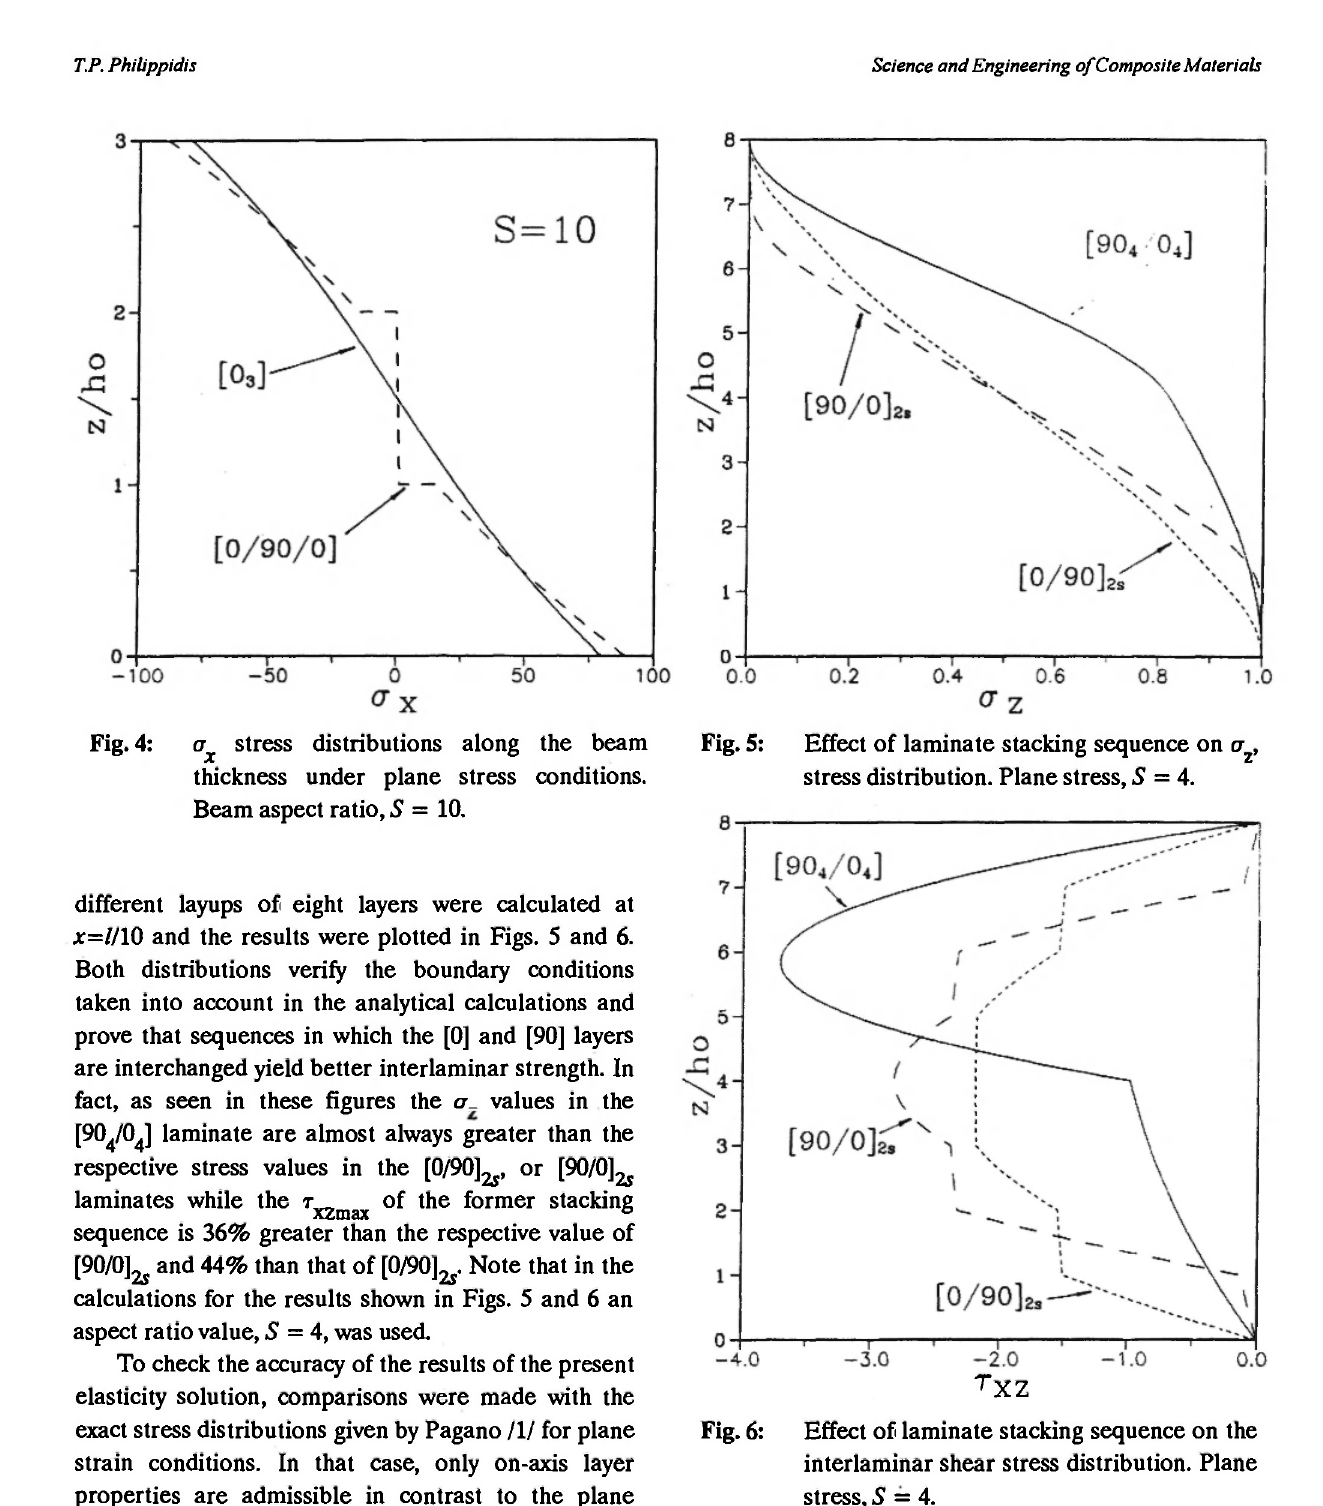
Fig. 6: Effect of laminate stacking sequence on the interlaminar shear stress distribution. Plane stress, 5 =